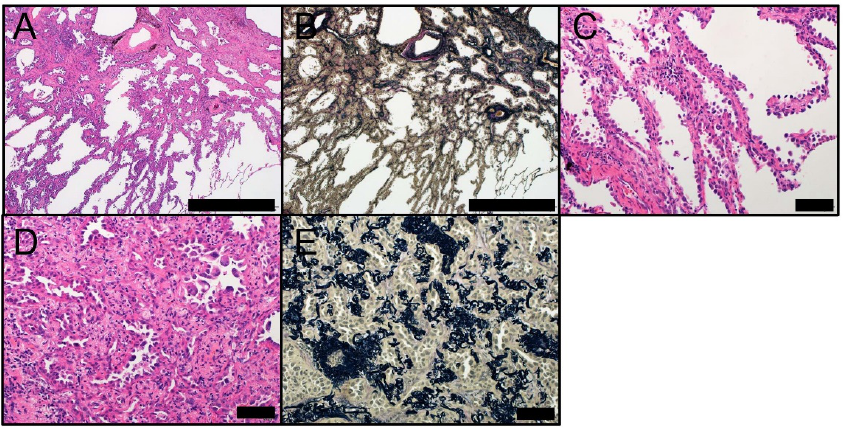
Figure 3. Morphology of MIA. MIA at low magnification (( A ) HE staining and ( B ) EVG staining) (Scale bar = 1000 µm). Lepidic component of MIA at high magnification (( C ) HE staining) and the (Scale bar = 1000 µ m). Lepidic component of MIA at high magnification (( C ) HE staining) and invasive component (( D ) HE staining and ( E ) EVG staining) (Scale bar = 100 µm). EVG, Elastic van Gieson; HE, hematoxylin and eosin; MIA, minimally invasive adenocarcinoma.